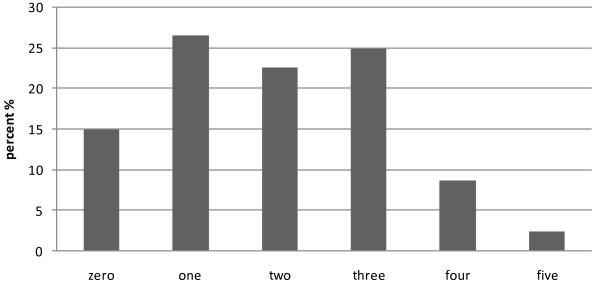
The number of ATPIII criteria in all drivers